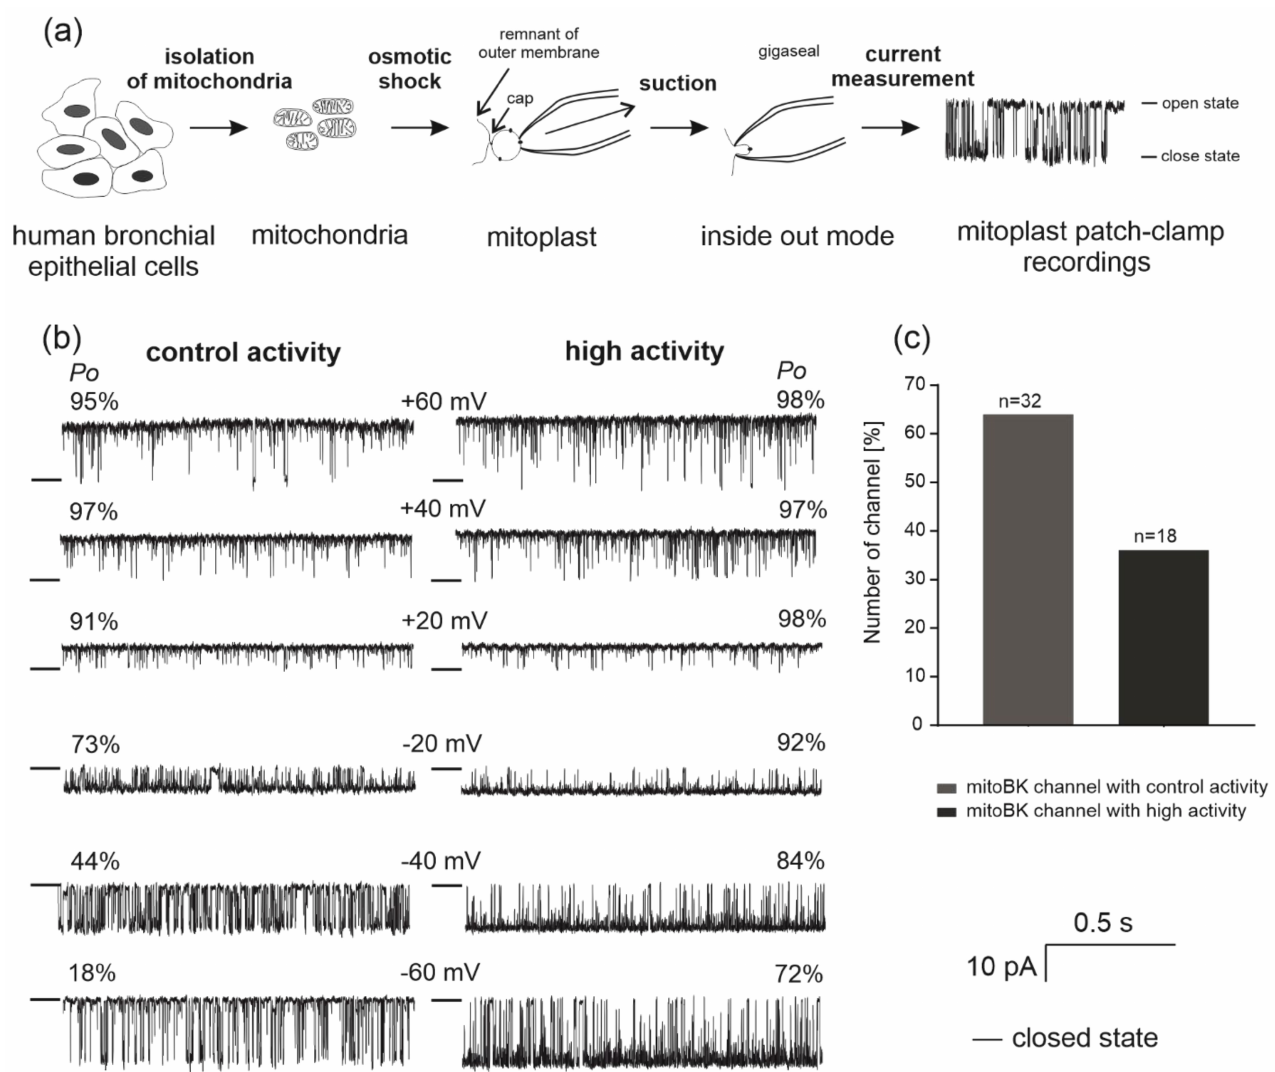
Figure 1. Outline of the mitochondrial patch-clamp experiments and comparison of the two types of recorded channel activities. ( a ) Scheme of the preparation of human bronchial epithelial mitochondria, mitoplasts, mitoplast patching, patch-clamp inside out mode and single-channel recordings. ( b ) Comparison of the two types of single-channel current-time recordings of the mitoBK Ca channel: control and high activity in a symmetric 150/150 mM KCl isotonic solution (in the presence of 100 µ M Ca 2+ ) at different voltages ( n = 10). “—” indicates a closed channel state. “ Po ” represents open probability analysis of single channel recordings. ( c ) Comparison of the numbers of mitoBK Ca channels observed with control ( n = 32) and high activity ( n = 18) in the analyzed